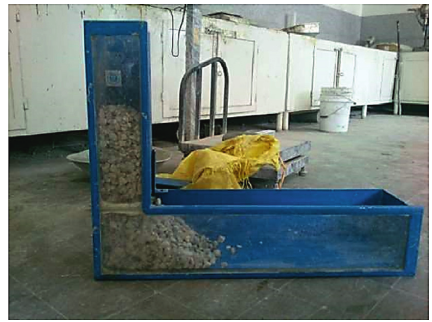
Figure 6: An example of “Keshtpour”